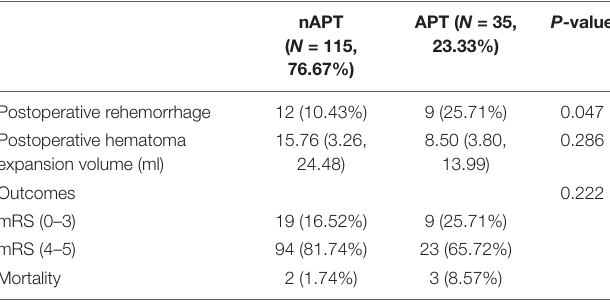
TABLE 2 | The association between preoperative APT and postoperative rehemorrhage or